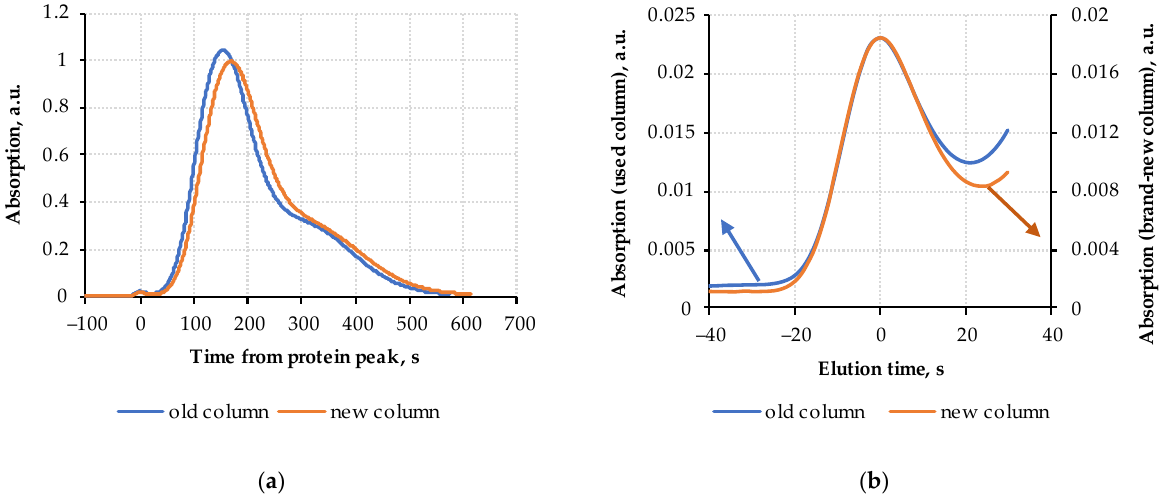
Figure 6. Human urine sample chromatograms ( a ) measured with a used (more than 200 samples) and brand-new PD-10 column; ( b ) Coincidence of urine protein peaks in the measurements with a used (left-side vertical axis) and brand-new (right-side vertical axis) column.